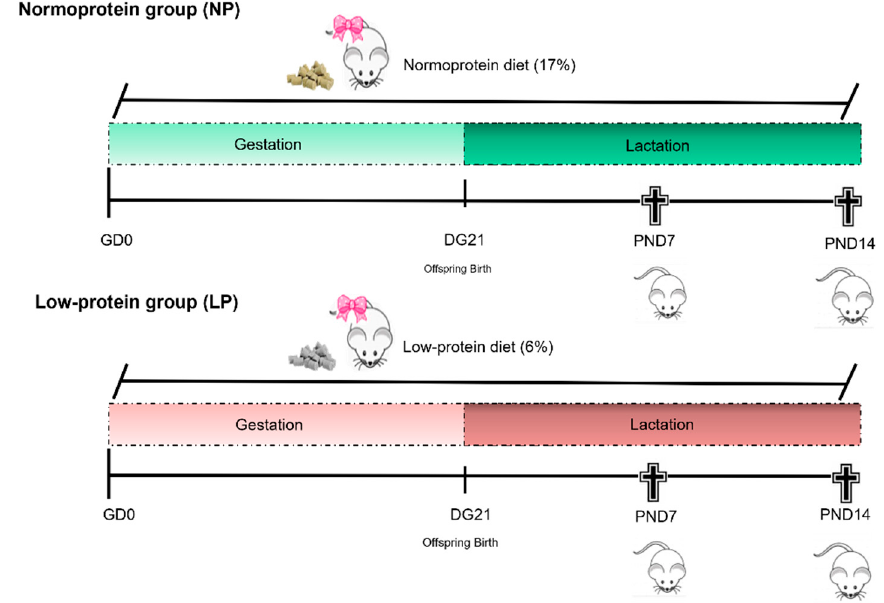
Figure 1. Illustration of the experimental design.